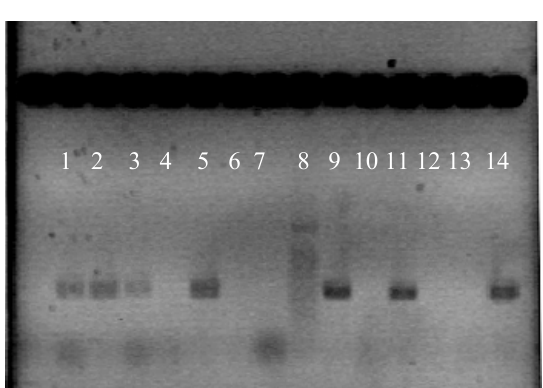
Figure 7. Species specific identification of Enterococcus faecium by PCR